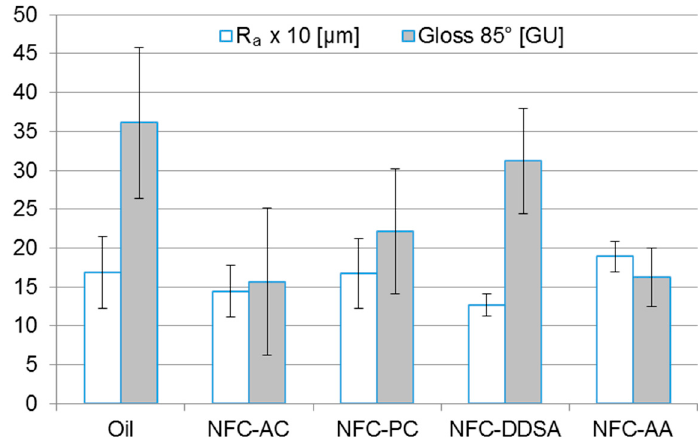
Figure 6. Arithmetic mean roughness ( R a ) and 85° gloss level of beech wood surfaces coated with linseed oil varnish containing 1 wt % NFC.